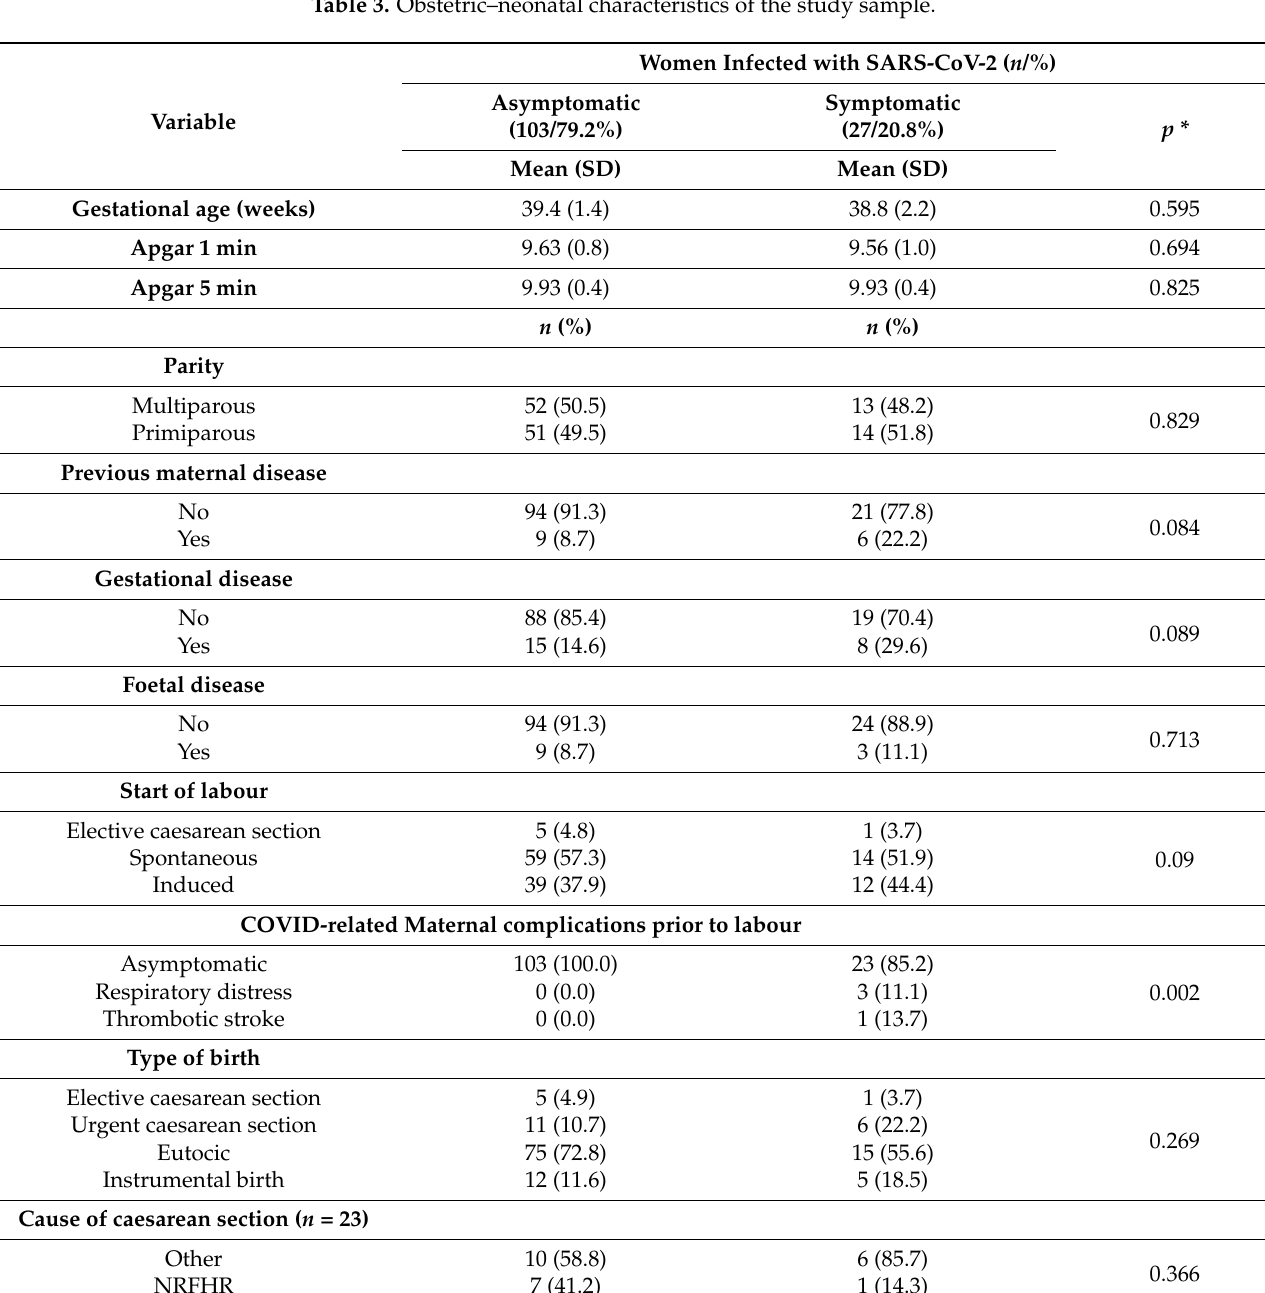
Table 3. Obstetric–neonatal characteristics of the study